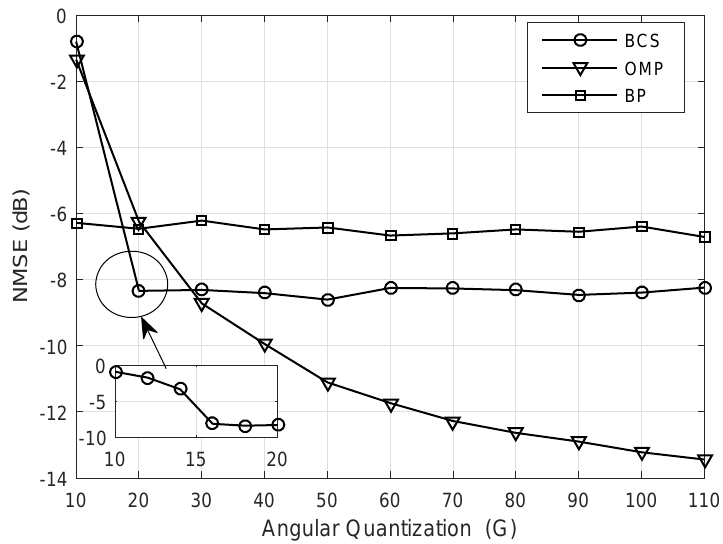
Figure 5. NMSE of the estimated CSI versus received angle quantization ( G ) with received SNR = 10 dB, sparseness L = 5, pilot symbol frames M = 40 and without hardware impairment.